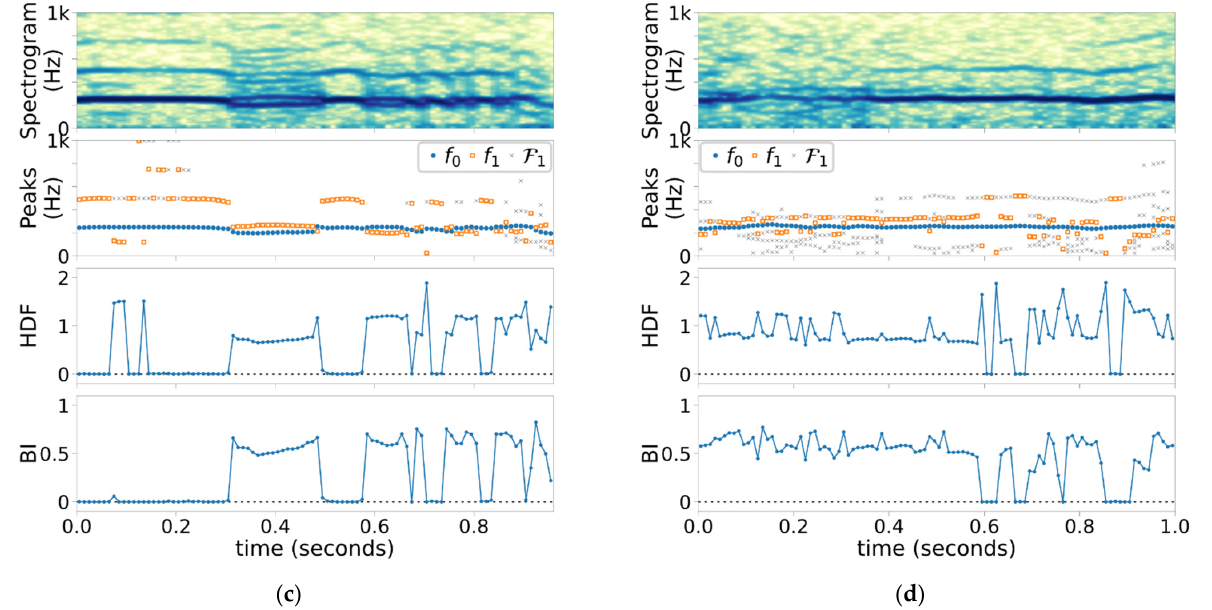
Figure 2. Spectrograms (color intensity range: 50 dB), detected f 0 and f 1 peak frequencies and f 1 candidates in F 1 , HDF’s, and BI’s of ( a ) Case 1 (Type I), ( b ) Case 2 (Types I and II), ( c ) Case 3 (Types I and II), and ( d ) Case 4 (Types I, II, and III).